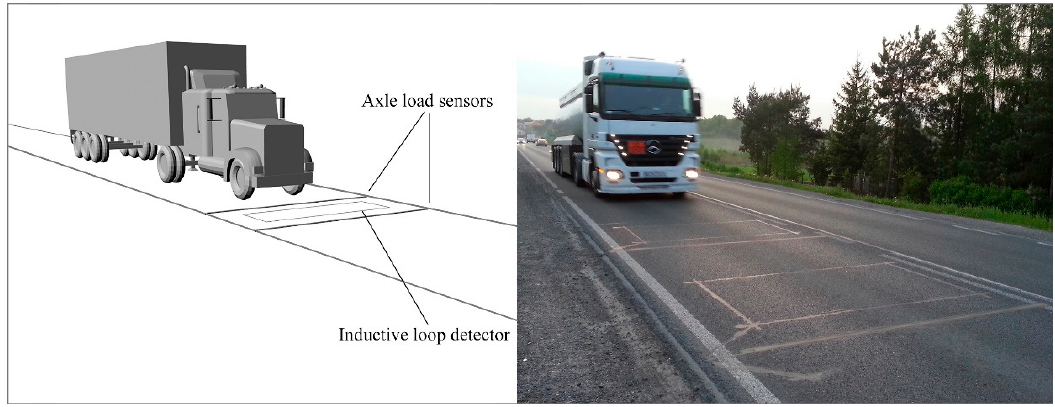
Figure 1. Diagram and photo of a WIM station.